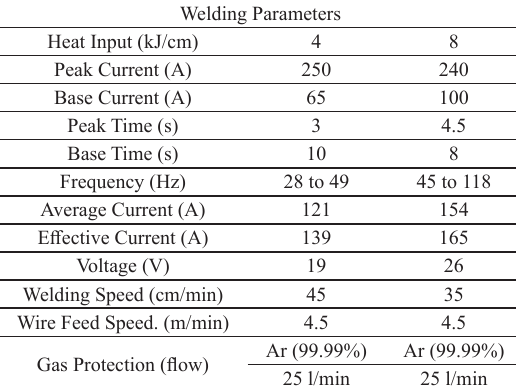
Figure 1. Microstructure of the HAZ of the welded joint with the AWS ER 2209 filler metal and heat input of 4KJ/cm.